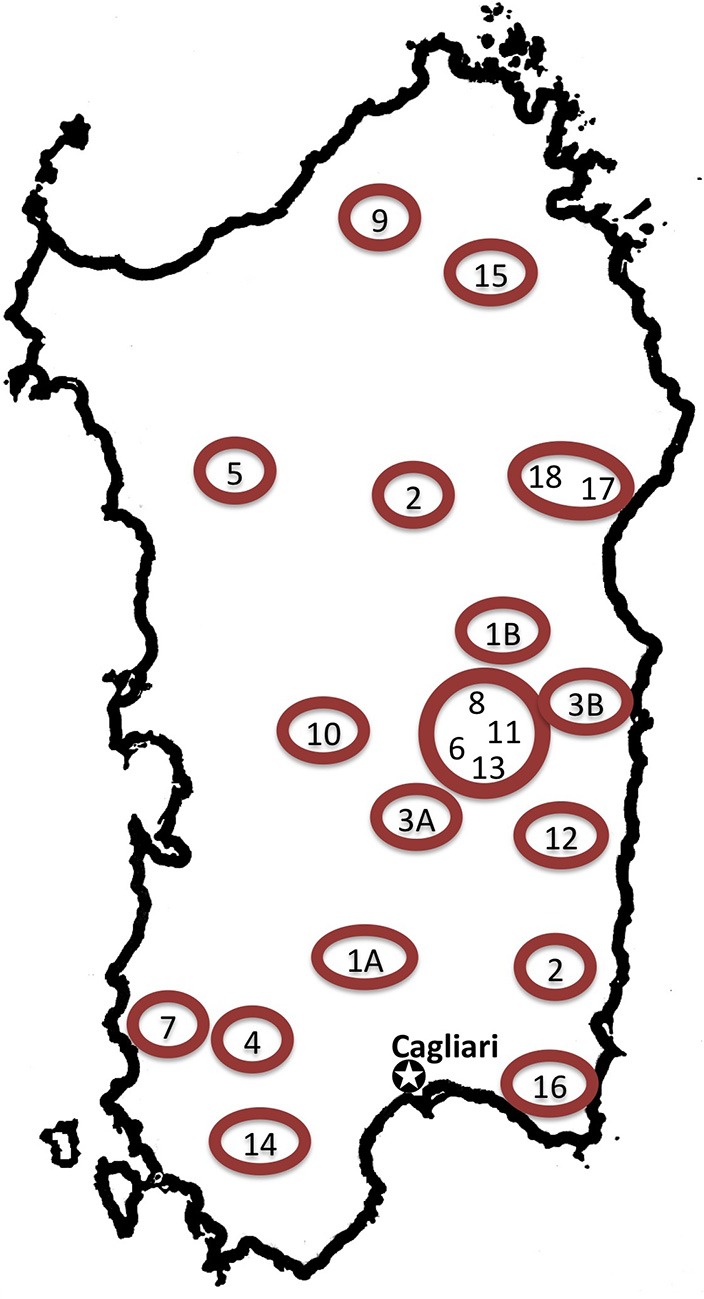
Map of Sardinia indicating considered field studies addressing popular medicinal plant use. 1A, Campidano; Cagliari (Bruni et al., 1997); 1B, Urzulei, Ogliastra (Bruni et al., 1997); 2, Sarrabus, Cagliari (Palmese et al., 2001); 3A, Escolca, Cagliari (Loi et al., 2005); 3B, Lotzorai, Ogliastra (Loi et al., 2005); 4, Marganai, Carbonia-Iglesias (Ballero and Fresu, 1991); 5, Monteleone, Sassari (Ballero and Poli, 1998); 6, Seui, Ogliastra (Ballero and Fresu, 1993); 7, Fluminimaggiore, Carbonia-Iglesias (Ballero et al., 2001); 8, Villagrande Strisaili, Ogliastra (Loi et al., 2004); 9, Tempio Pausania, Olbia-Tempio (Ballero et al., 1997); 10, Laconi; Oristano (Ballero et al., 1997); 11, Arzana, Nuoro (Ballero et al., 1994); 12, Perdasdefogu, Ogliastra (Ballero et al., 1997); 13, Ussassai; Ogliastra (Ballero et al., 1998); 14, Carbonia-Iglesias (Atzei et al., 1994); 15, Gallura; Olbia-Tempio (Atzei et al., 1991); 16, Villasimius, Cagliari (Ballero, 1982); 17, Dorgali (Camarda, 1990); 18, Monte Ortobene, Nuoro (Signorini et al., 2009).